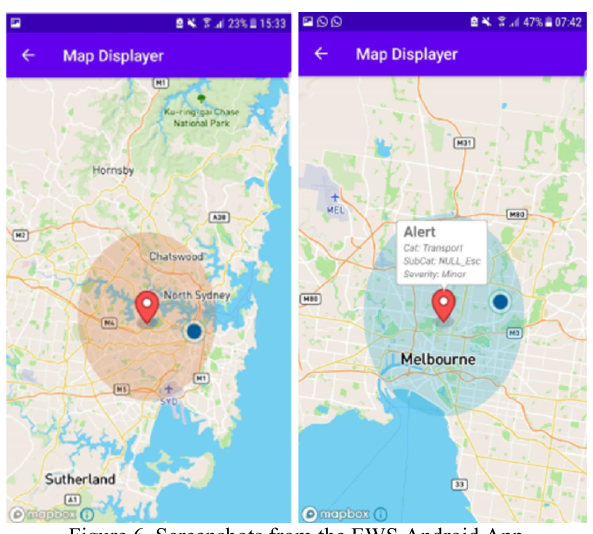
Figure 6. Screenshots from the EWS Android App